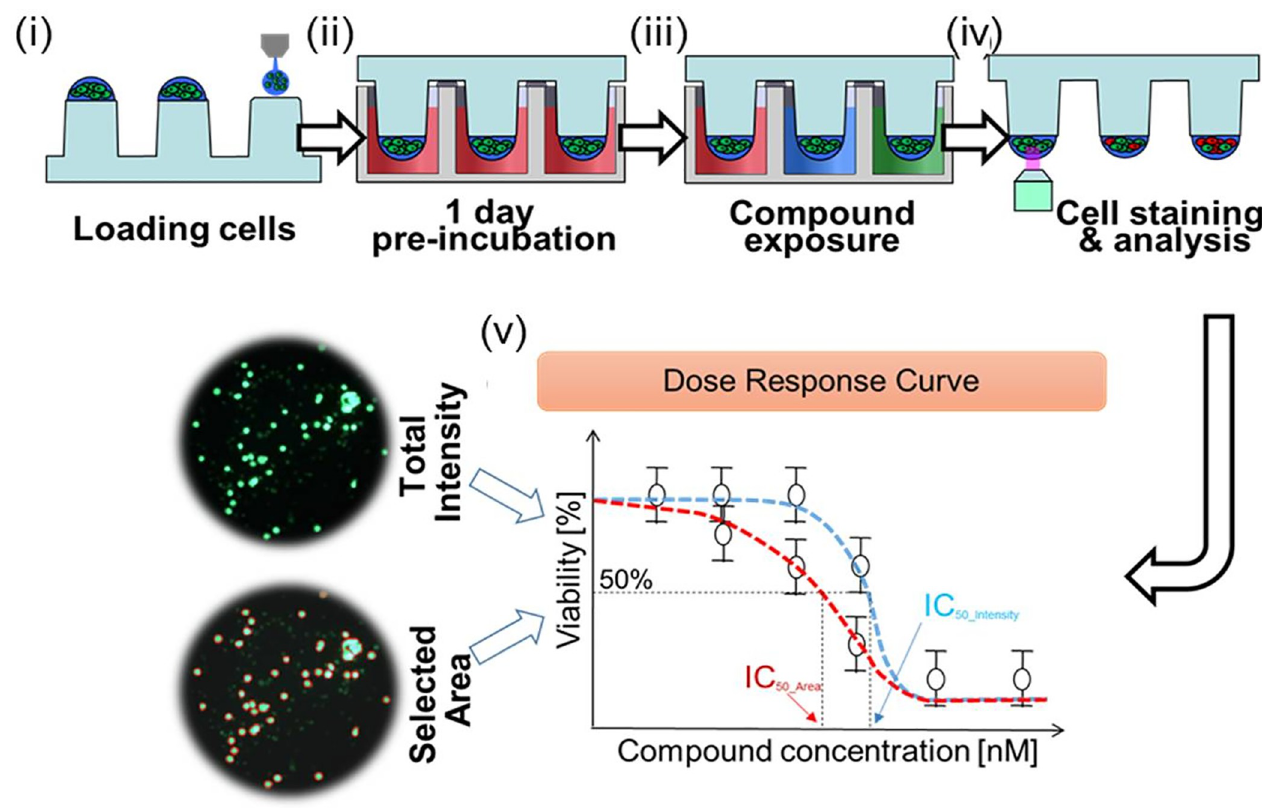
Fig 1. Schematic view of 3D cell based micropillar/microwell chip platform for high-throughput screening and experimental procedure. (i) Cells are dispensed and immobilized in alginate onto the top of the micropillars and (ii) dipped in the microwells containing growth media for 1-day culture by sandwiching the micropillar and microwell chips. (iii) Compounds are dispensed into the microwells and cells are exposed to the compounds by moving the micropillar chip to a new microwell chip. (iv) 3D-cultured cells are stained with Calcein AM, and the dried alginate spot on the micropillar chip is scanned for data analysis. (v) Dose response curve and IC 50 calculation based on total intensity and selected